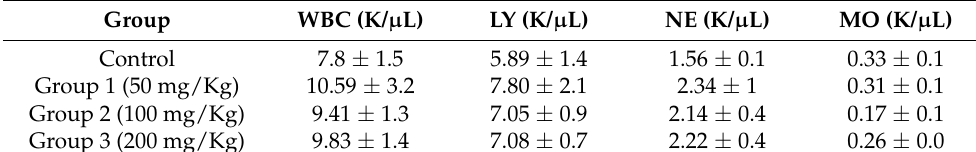
Table 10. Effect of the administration of a novel nutraceutical in three different concentrations on the total numbers of leukocytes (WBC), lymphocytes (LY), neutrophils (NE) and monocytes (MO) in mice.